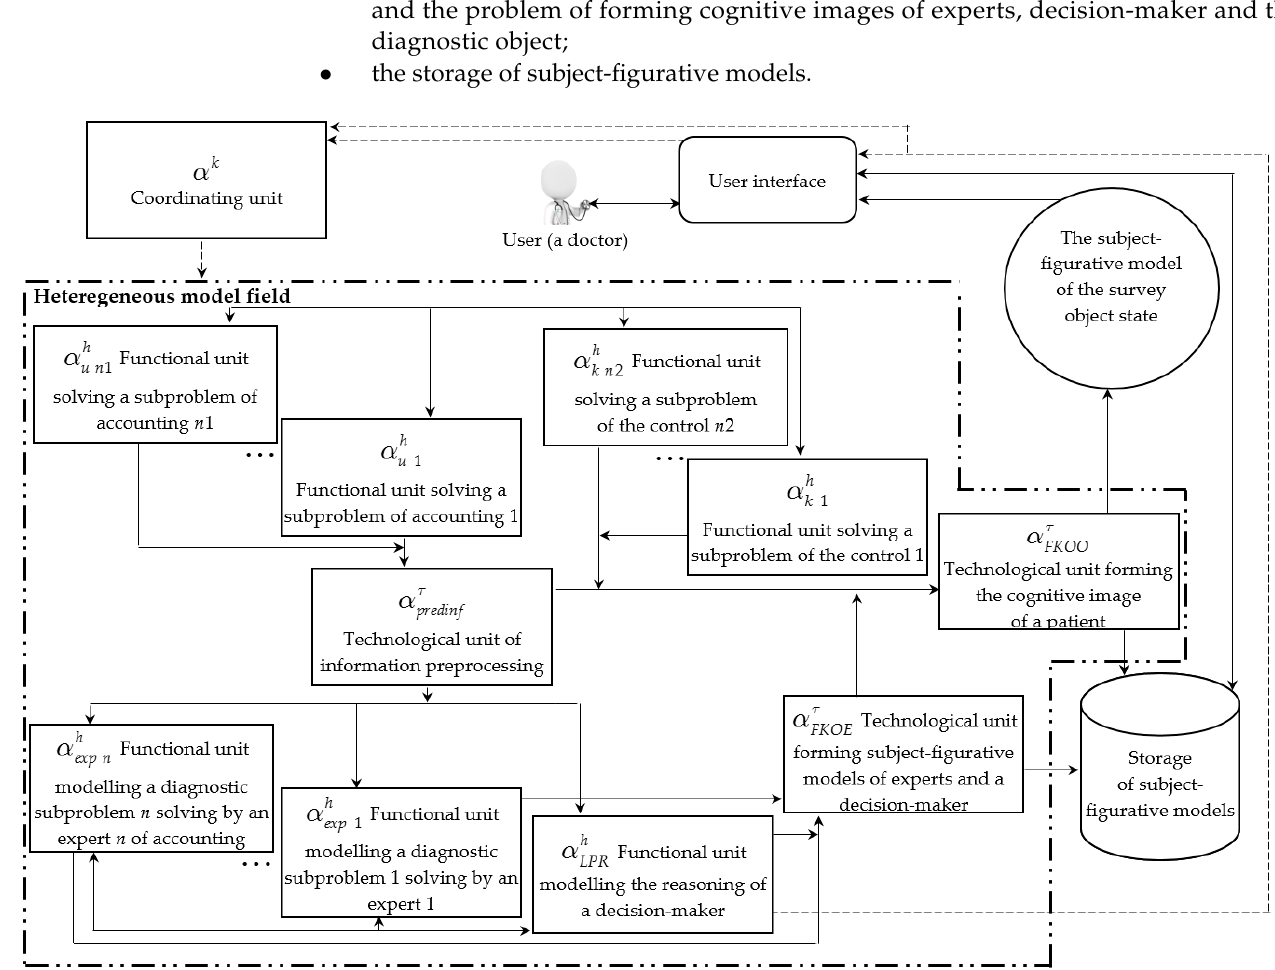
Figure 3. Cognitive hybrid intelligent diagnostic system. Typical architecture.